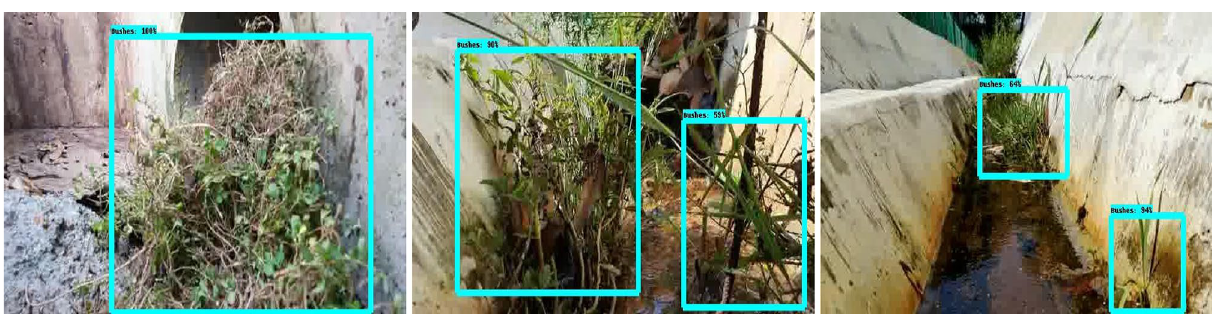
Figure 16. Bushes detection on real time drain inspection field test (day).